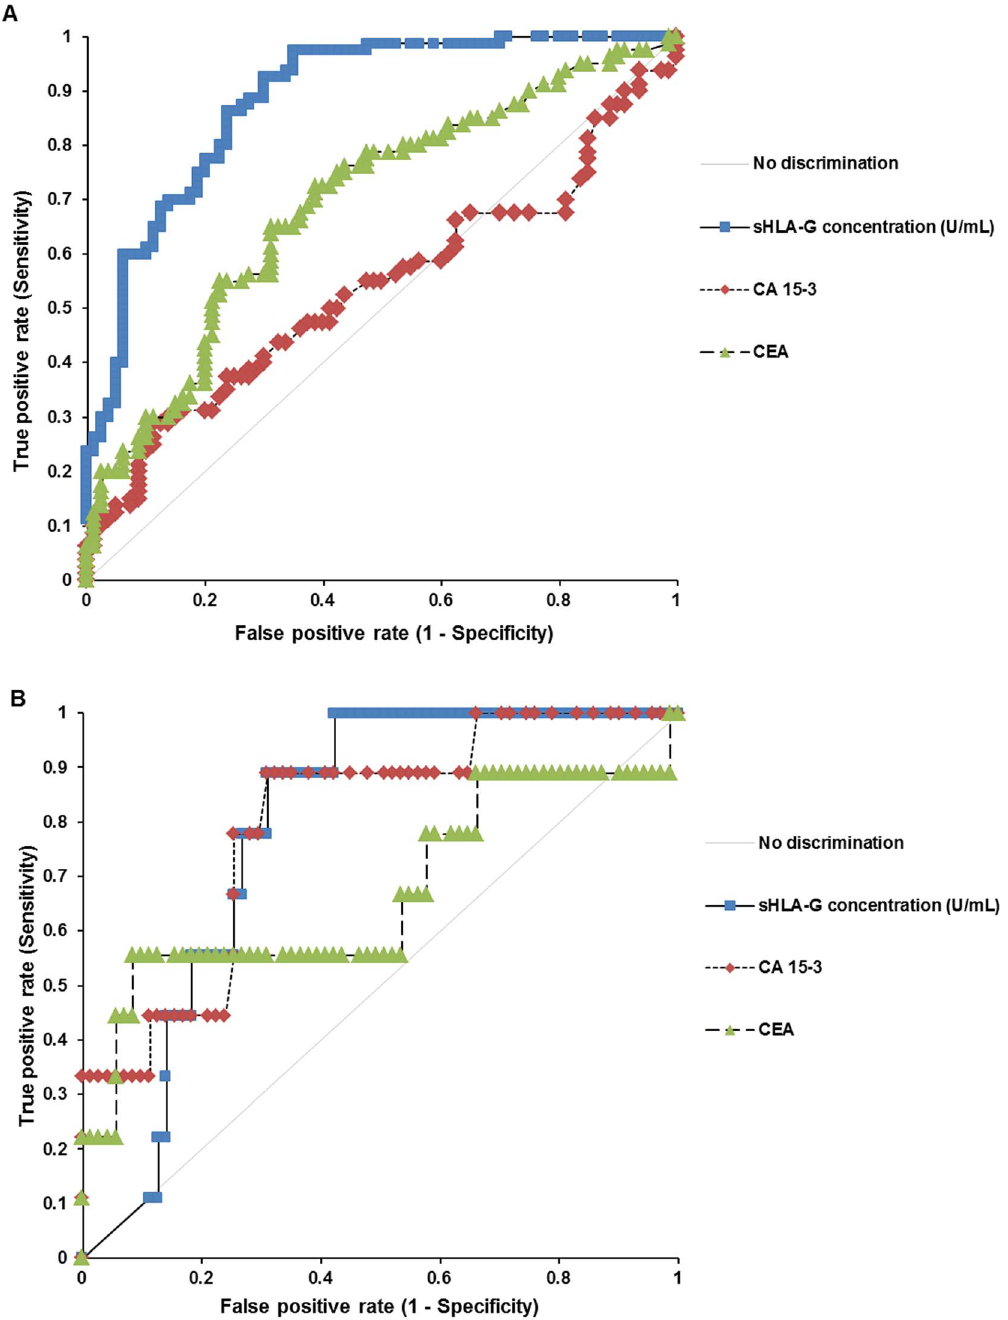
Figure 2. The AU-ROCs of sHLA-G, CA15-3, and CEA for predicting breast cancer. (A) The AU-ROC of sHLA-G for discriminating the breast cancer group (n=80) from the control group (n=80) was 0.89 (95% CI=0.83 to 0.94, P , 0.001), and was greater than those of CA15-3 (0.54, 95% CI=0.45 to 0.63, P =0.2116) and CEA (0.69, 95% CI=0.61 to 0.78, P , 0.001). (B) The AU-ROCs of sHLA-G, CA15-3, and CEA for differentiating metastasis (n=9) from other groups (n=71) were 0.79 (95% CI=0.68 to 0.90, P , 0.001), 0.80 (95% CI=0.65 to 0.95, P , 0.001), and 0.67 (95% CI=0.43 to 0.91, P =0.0837), respectively. doi:10.1371/journal.pone.0098284.g002 results on the association between G*01:01:02 heterozygote genotype and cervical cancer (OR =0.92, 95% CI =0.50–1.68) [21].